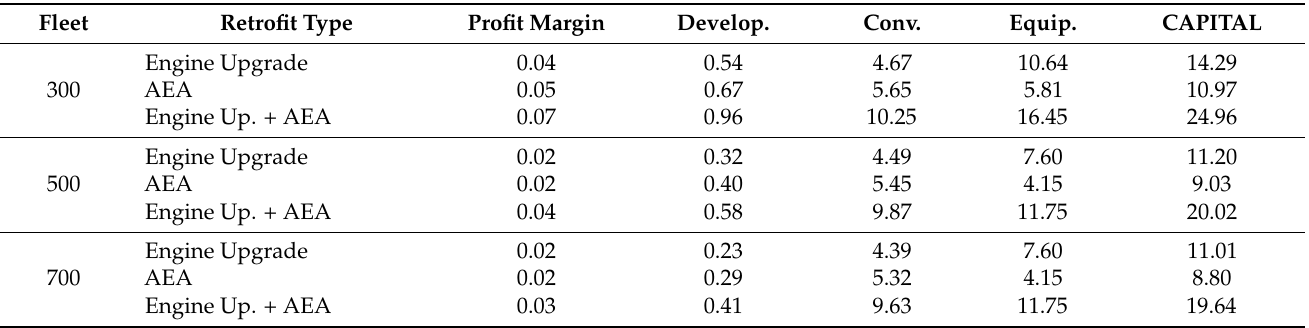
Table 13. The capital costs derived from three different retrofitting activities. The costs are expressed in million EUR and are related to a single aircraft belonging to one of three fleets. Profit Margin Develop. Conv. Equip.